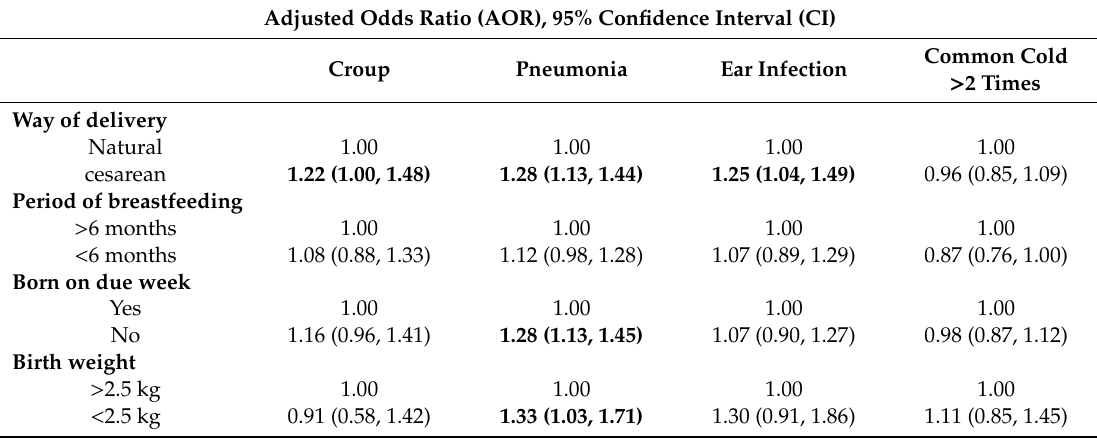
Table 4. Associations between children’s biological factors and respiratory